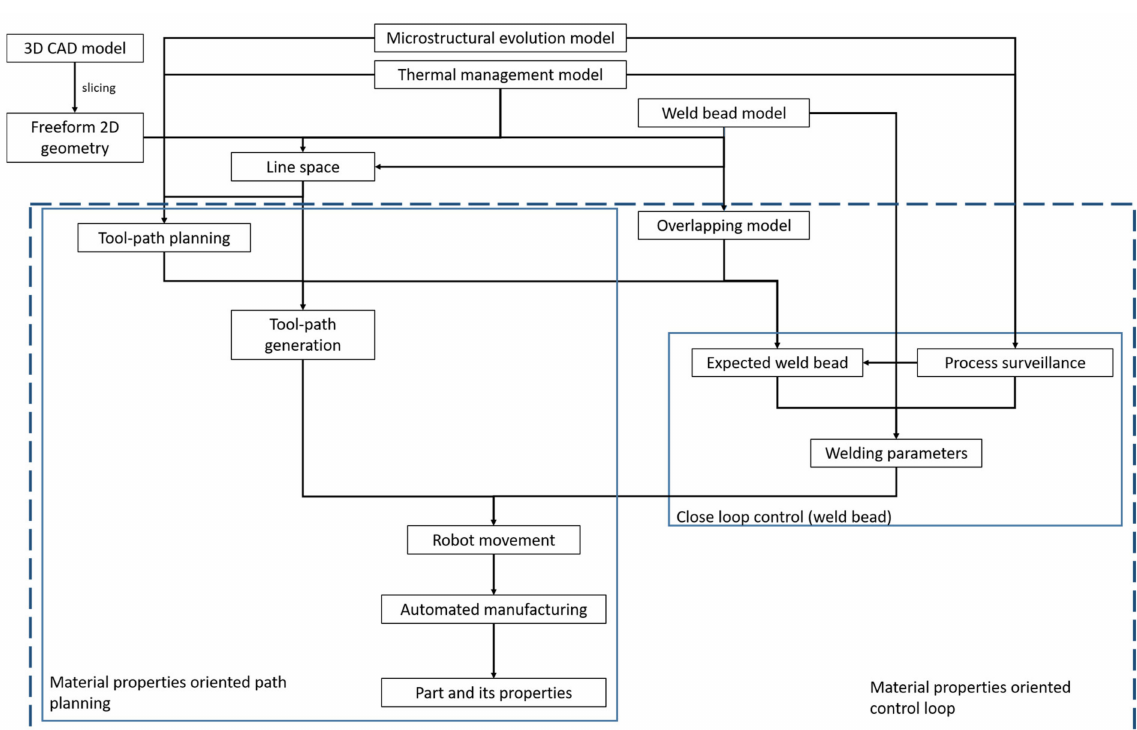
Figure 8. Process path for WAAM (modified, based on